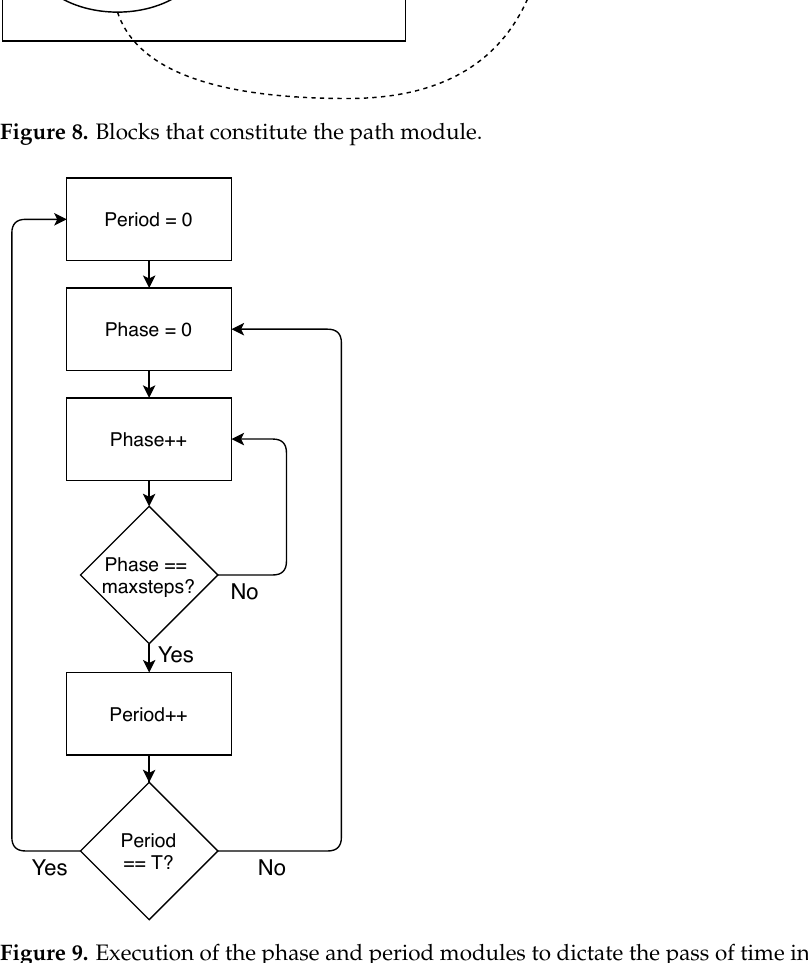
Figure 9. Execution of the phase and period modules to dictate the pass of time in the